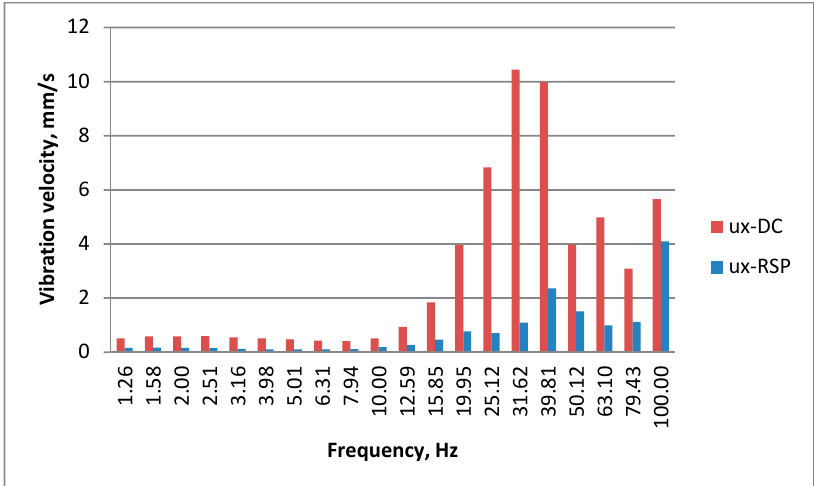
Figure 11. Result of the third octave analysis for the horizontal y component at station 1.